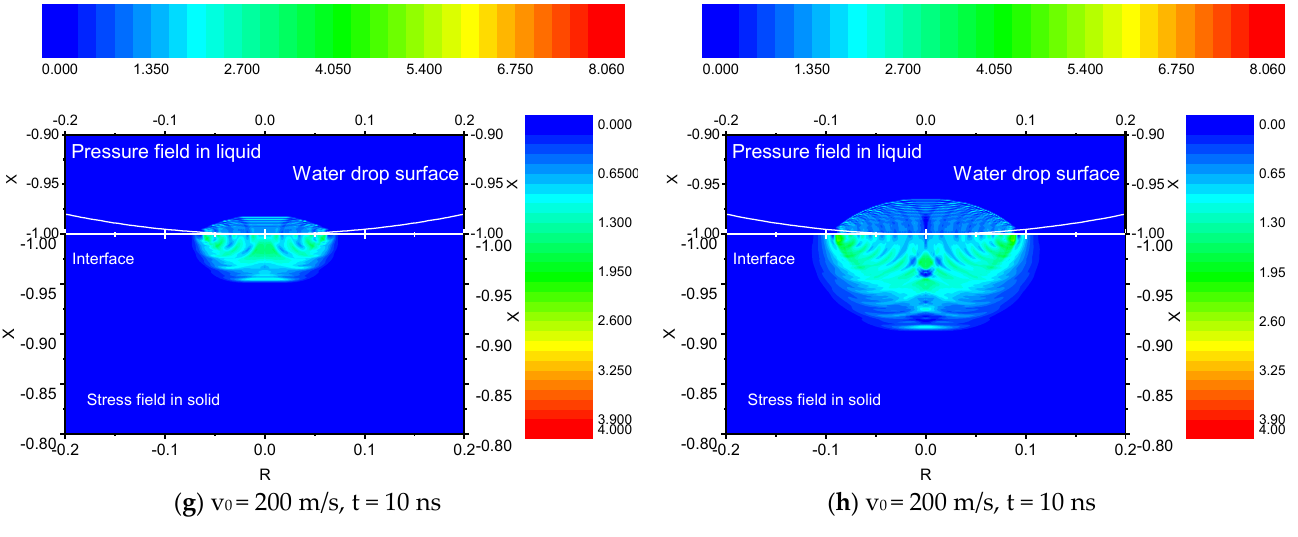
Figure 3. Cloud diagrams of the pressure distribution inside the droplet and the stress distribution inside the scale under diverse impact velocities (r 0 = 1 mm; the unit of x and R in the figure is mm). Under all the impact velocity conditions, the pattern characteristics of the t = 10 ns and t = 20 ns time layers are similar, except that the disturbance area of the t = 20 ns time layer is larger.